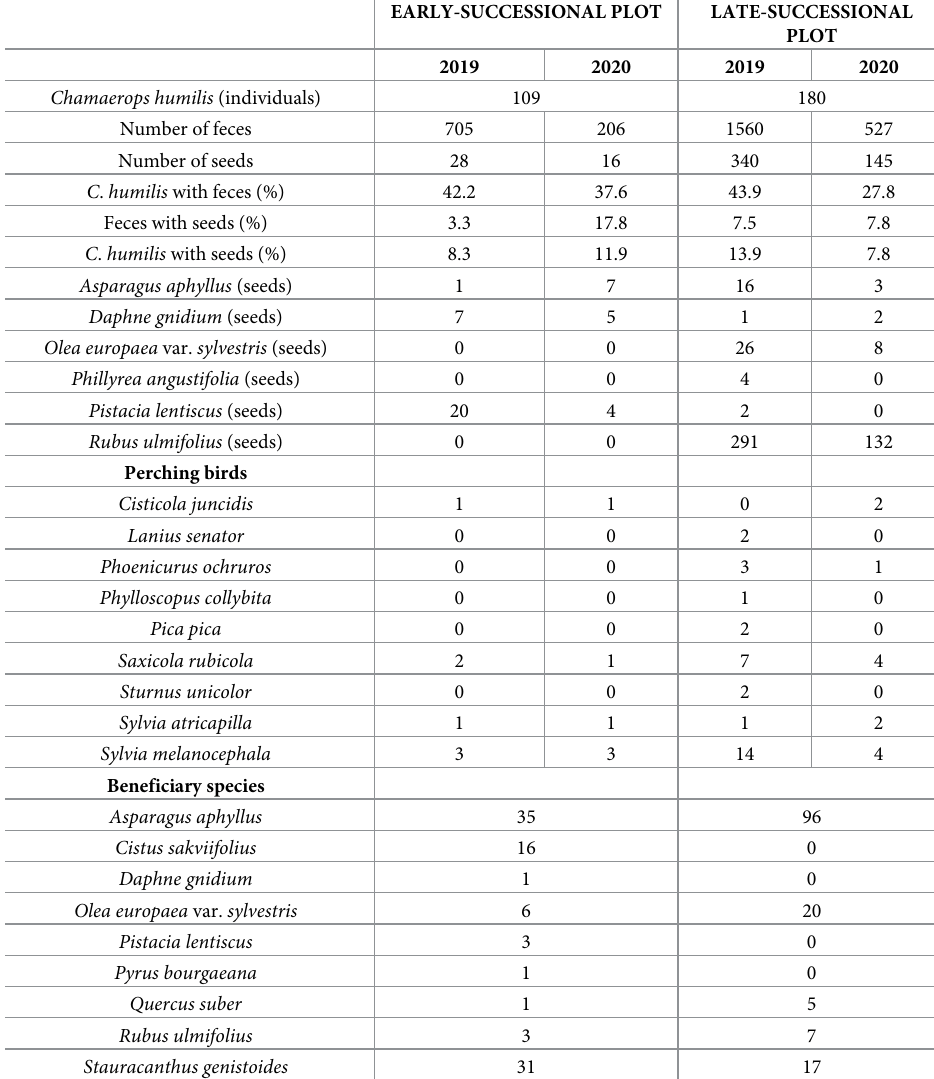
Table 1. Summary of collected